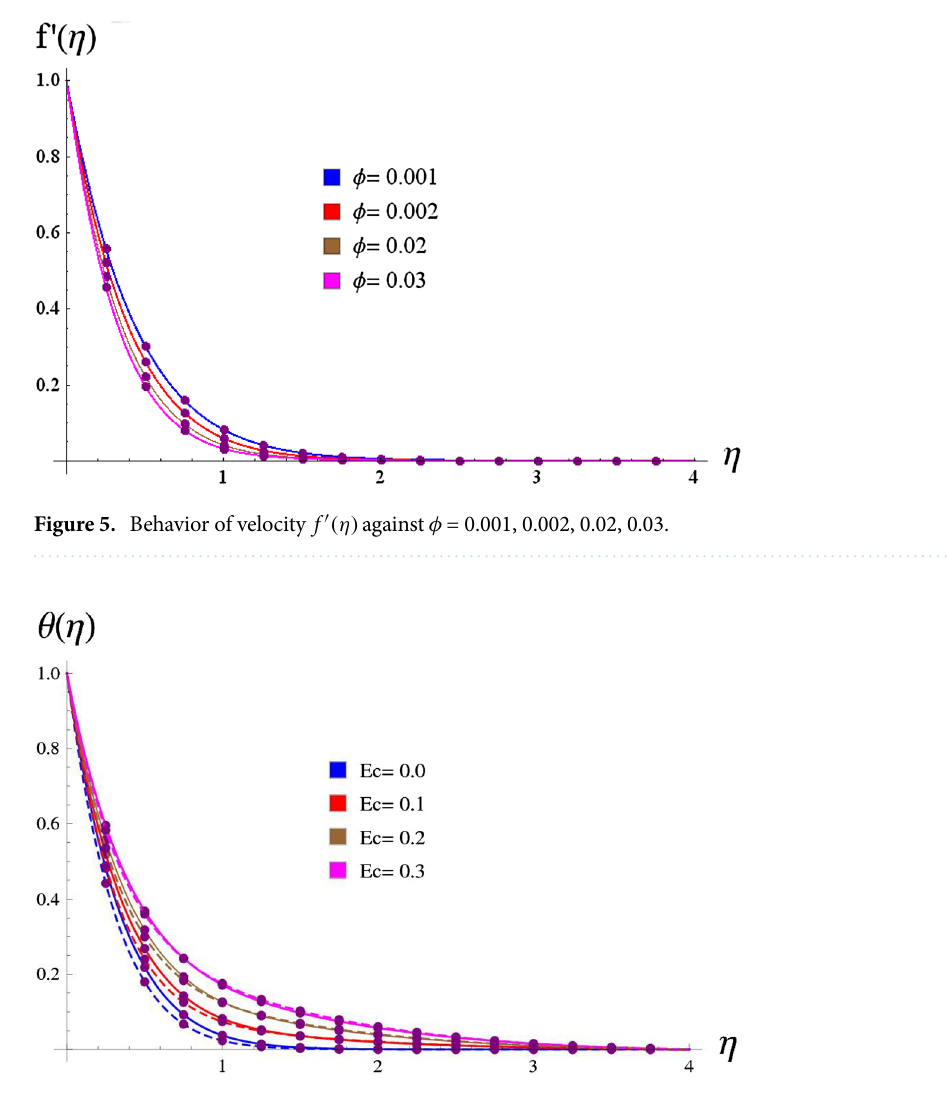
Figure 6. Behavior of temperature θ(η) against Ec = 0.0, 0.1, 0.3,